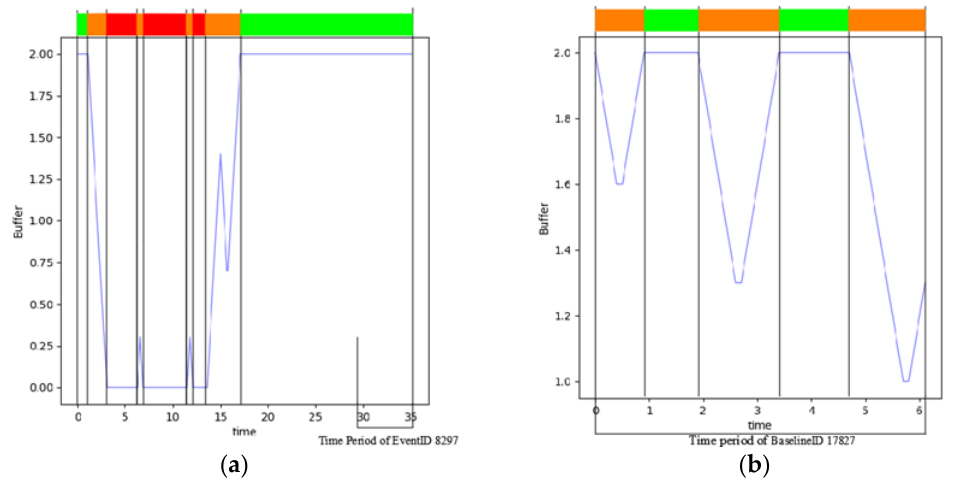
Figure 3. Changes in drivers’ visual buffer and distractions in different IDs: ( a ) EventID 8297 Driver Visual Buffer; ( b ) BaselineID 17,827 Driver Visual Buffer.